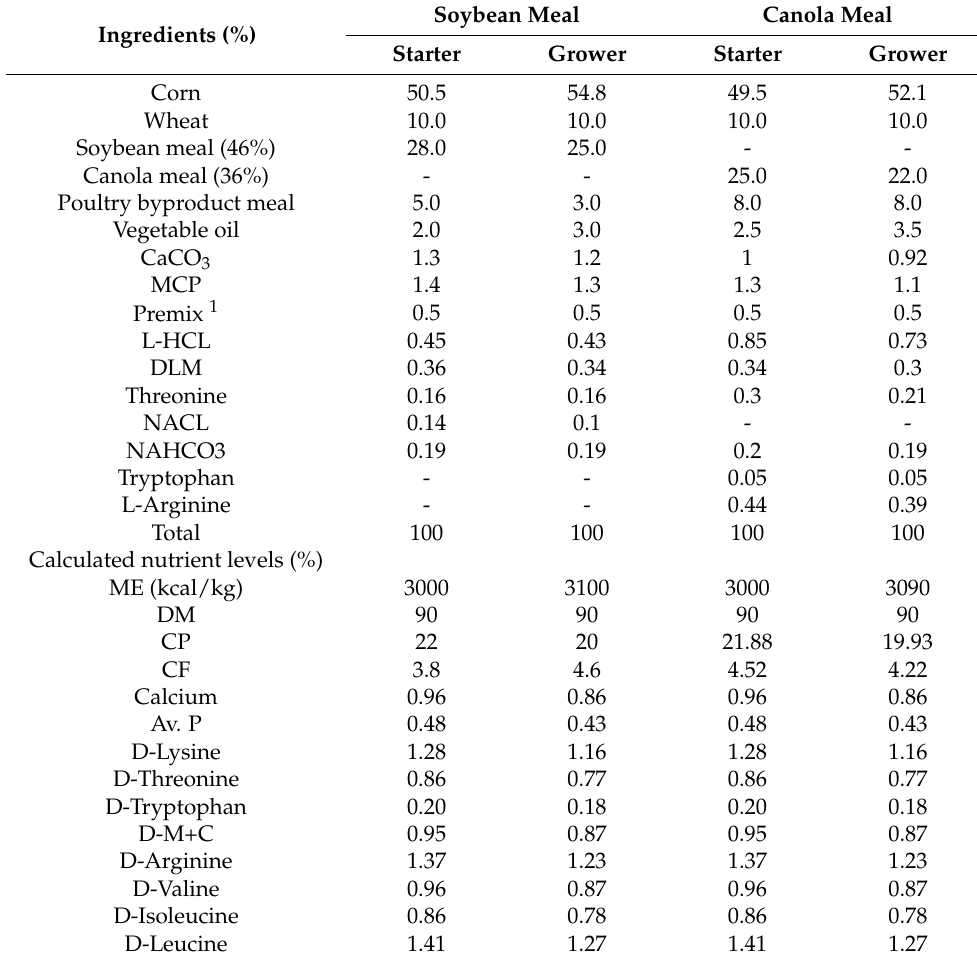
Table 1. Ingredients and nutrient contents of the experimental diets (as-fed